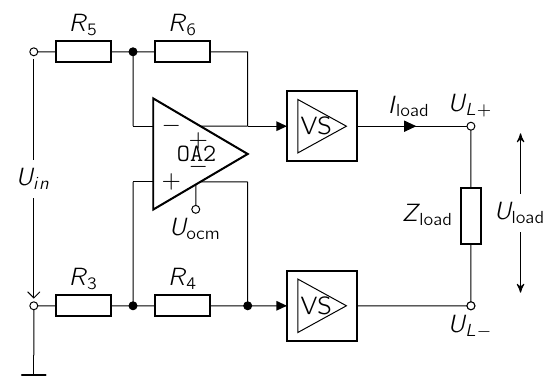
Figure 4: The symmetric input signal of the two VSs (of Figure 3) is generated by the fully differential amplifier OA2. The output signals, running in 180 ◦ phase reversal, control two single-ended VSs driving the Z load